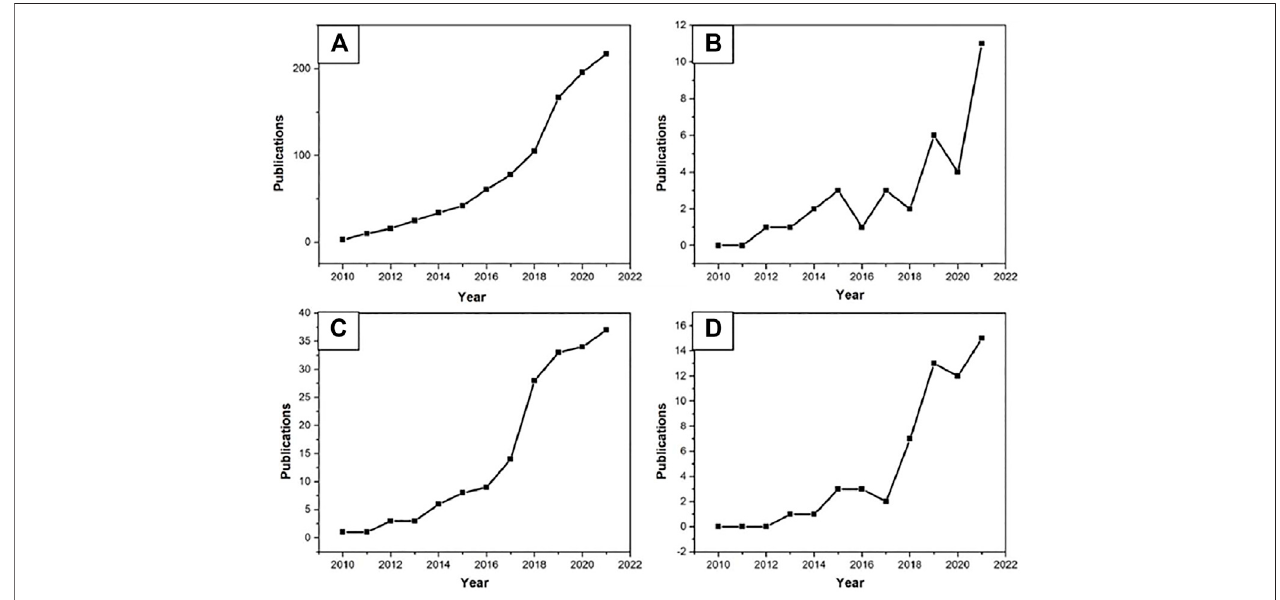
FIGURE 1 | Number of publications from the Web of Science database from 2010 to 2021 based on the topic search category. (A) ‘ spent coffee ground* ’ , (B) ‘ spent coffee ground* ’ and ‘ pellet ’ , (C) ‘ spent coffee ground* ’ and ‘ biodiesel ’ , (D) ‘ spent coffee ground* ’ and ‘ biore fi nery. ’